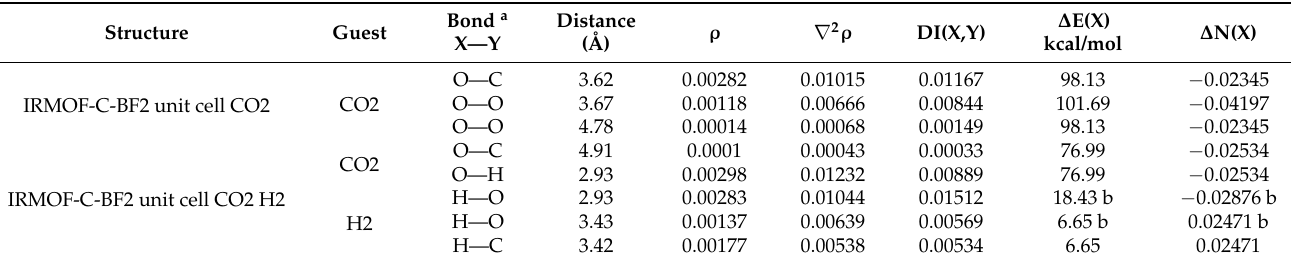
Table 9. Topological parameters of the BCP of bond in adsorption configurations of guest molecules (CO 2 and H 2 ) on fragments of unit cells. Structure